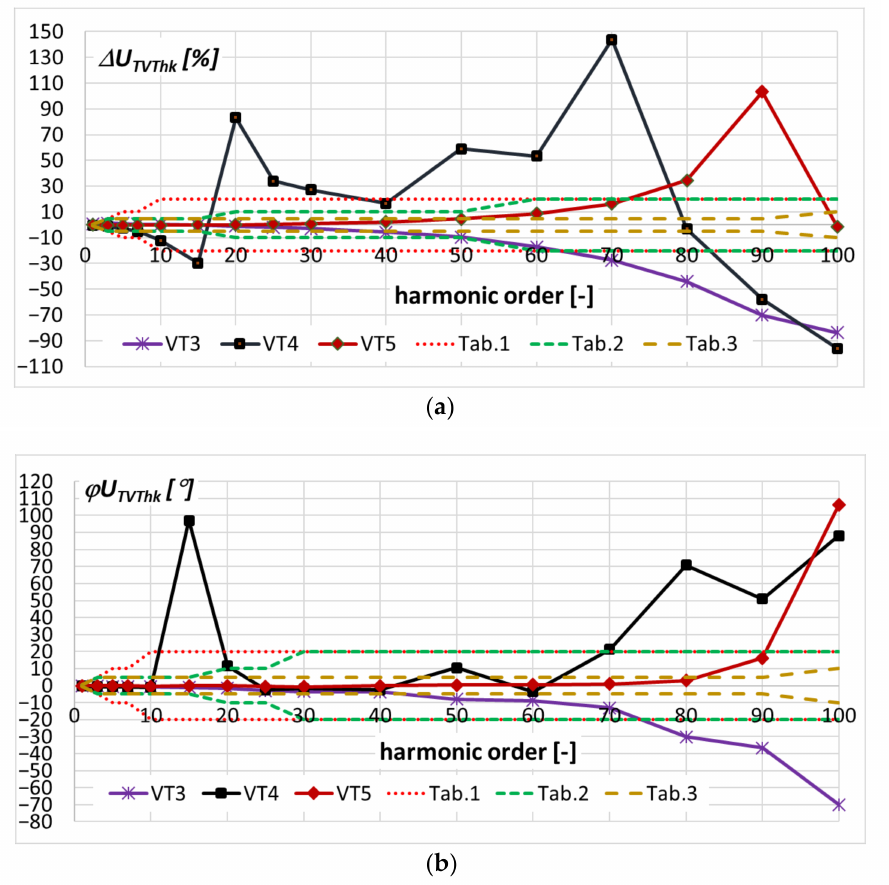
√ 3) kV: ( a ) voltage error,